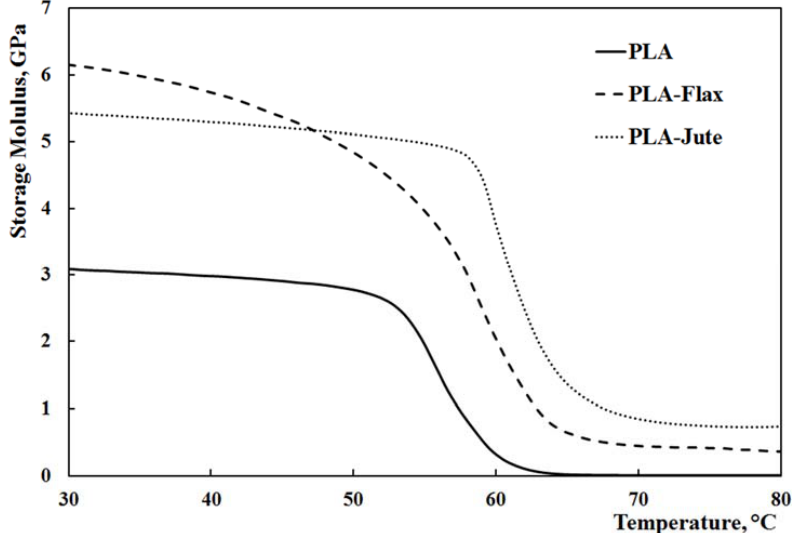
Figure 2. Storage modulus E’ versus temperature trends.